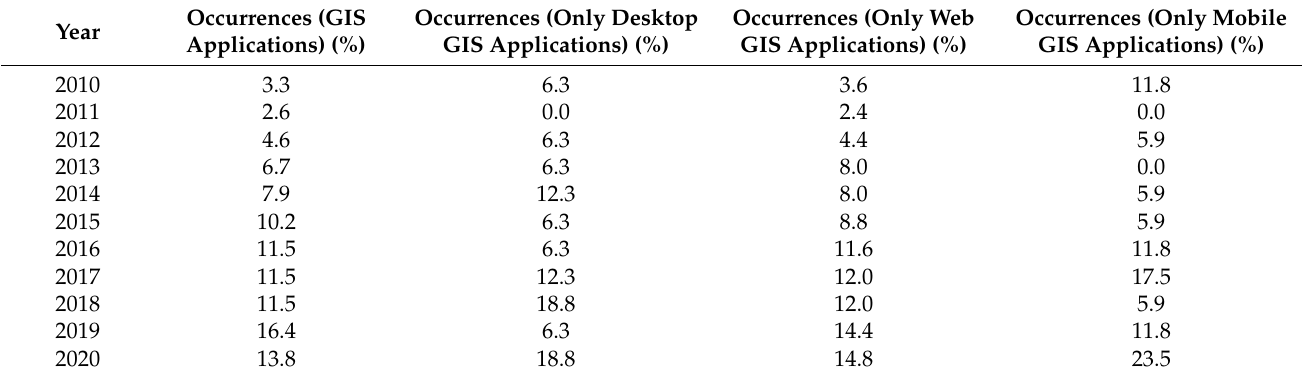
Table 2. Occurrences of publications during 10 years (in percentage), regarding the general GIS applications, Web GIS applications and mobile GIS